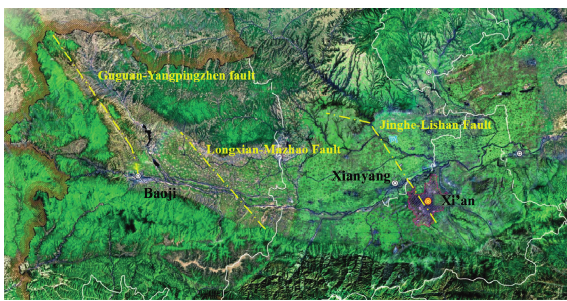
Figure 1: Geological structure characteristics in Weibei